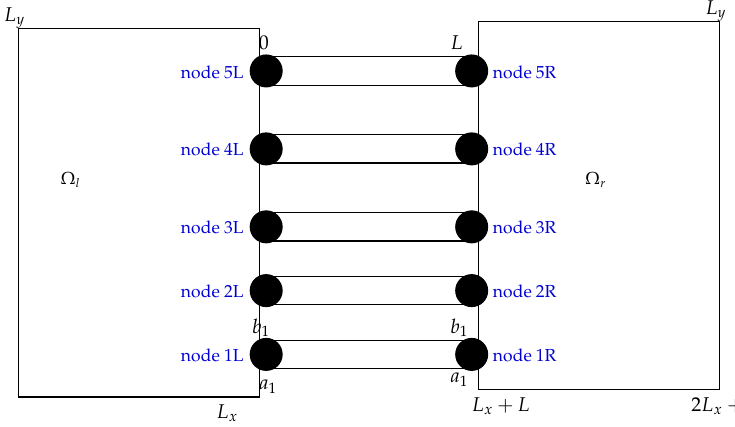
Figure 2. Simplified schematization of the chip geometry depicted in Fig. 1.